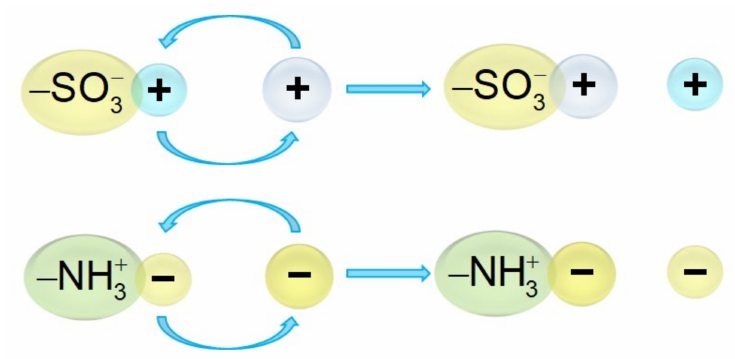
Figure 2. Schematic representation of exchange reactions on fixed membrane